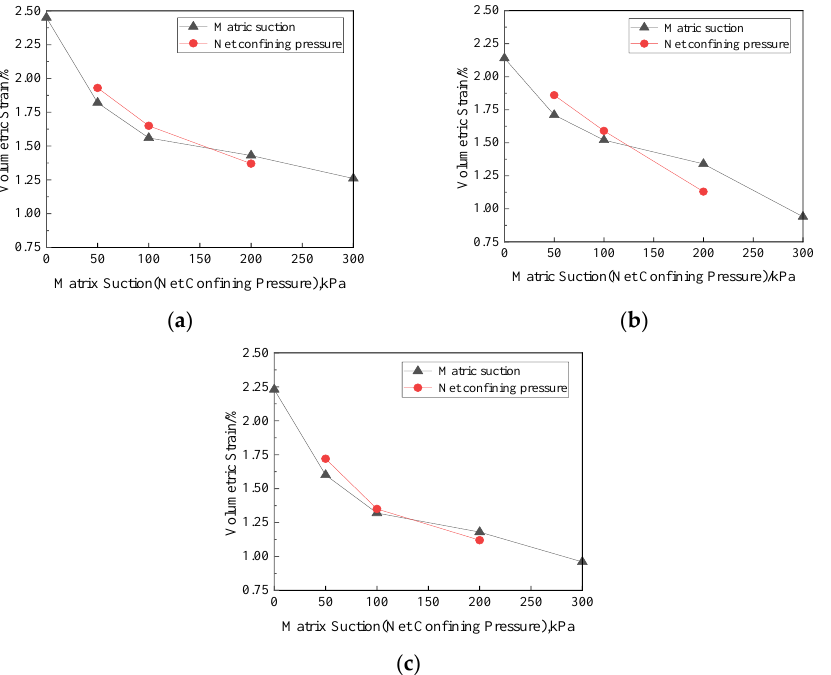
Figure 13. Relationships of matric suction or net confining pressure and volumetric strain. ( a ) Fiber length = 6 mm, ( b ) fiber length = 12 mm, ( c ) fiber length = 19 mm.